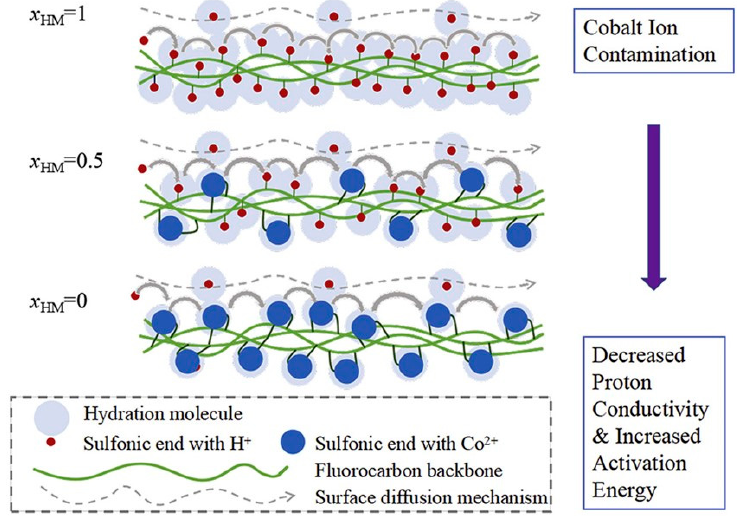
Figure 2. The schematic diagram of proton conduction mechanism for ultrathin Nafion film [70].